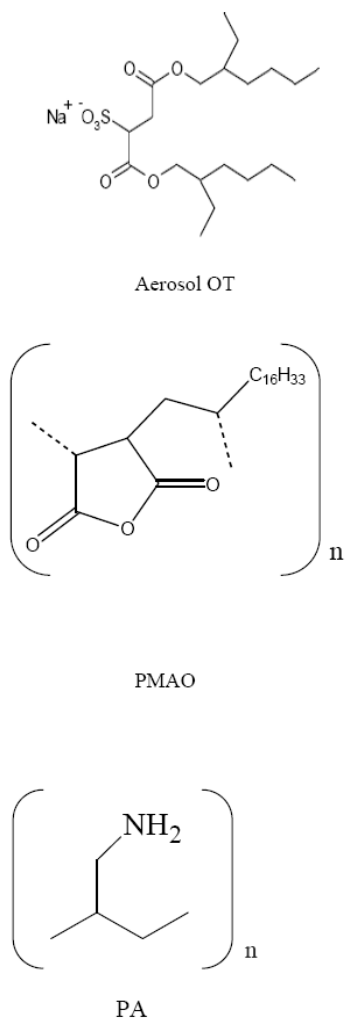
Scheme 1. Molecular structures of the surfactant Aerosol OT and the polymers: poly(maleic anhydride-alt-1-octadecen) (PMAO) and poly(allylamine)